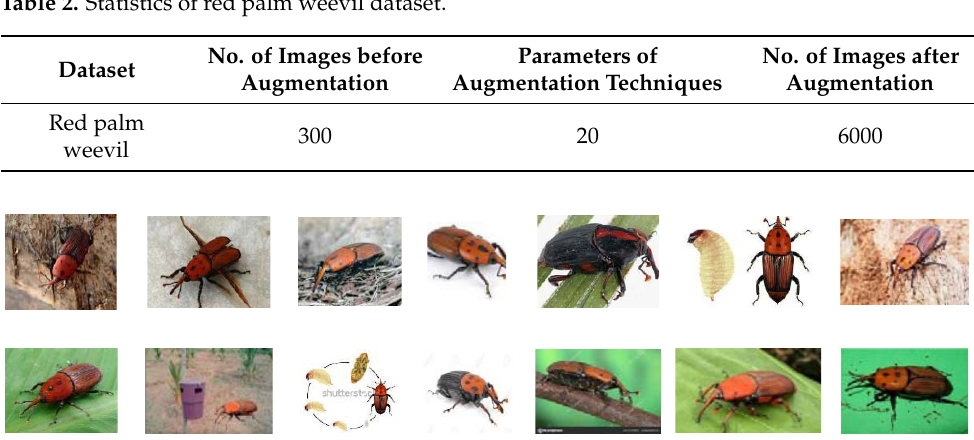
Figure 3. RPW dataset for the developed